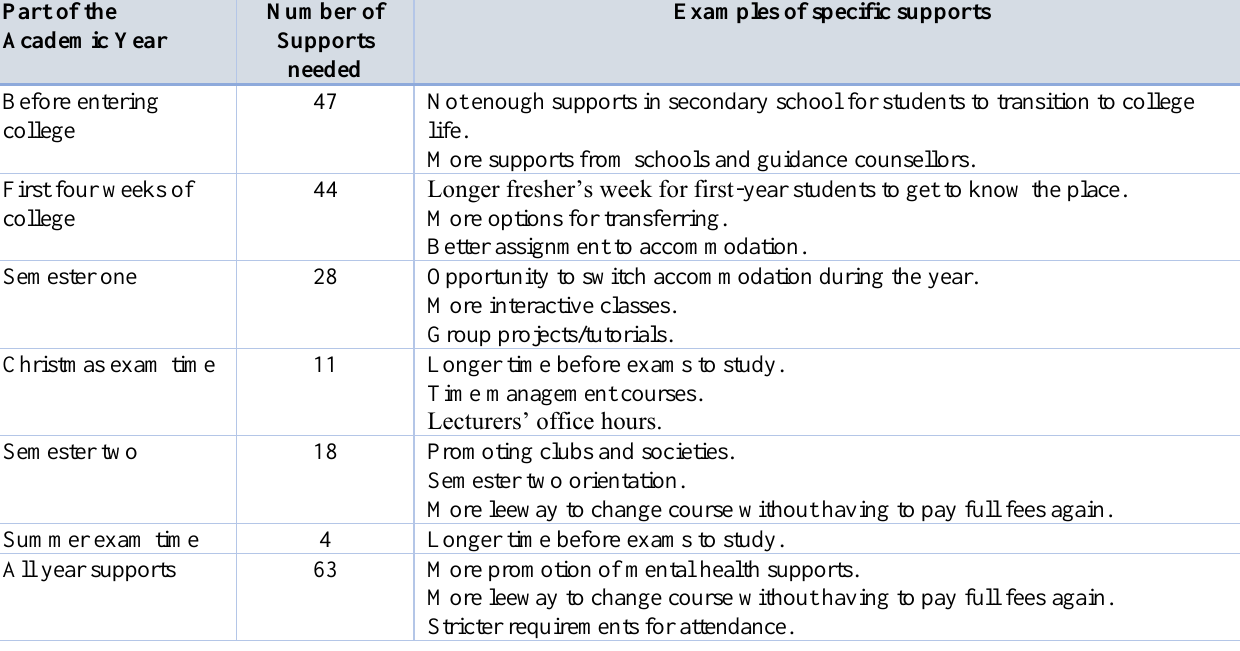
Workshop 2 Timeline of Supports